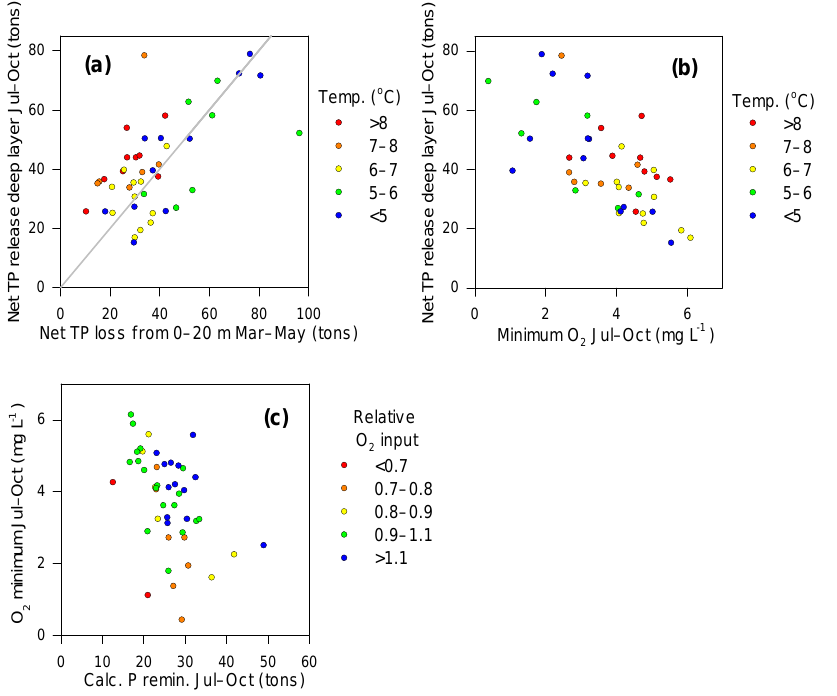
Figure 8. (a) Annual net total phosphorus (TP) release (t) in deep water ( > 20m) in July–October, as a function of net TP loss (t) from the layers 0–20m in March–May 1969–2015 (1970 excluded as an outlier (P loss 222t), 1975 excluded due to lack of data, and 2011 excluded due to unreliable data). The colour code shows mean bottom water temperature for July–October (station K, 24–32m; see Fig. 3). There is a significant linear regression, y = 19 . 8 + 0 . 55 x , r 2 = 0.38, p < 0.0001. Only the 1:1 line is shown in the graph. (b) Annual net TP release in deep water for July–October (t) as a function of the minimum oxygen (O 2 ) concentration (mgL − 1 ). Colour-coded as in (a) . There is a significant linear regression, y = 73 . 2 − 8 . 50 x , r 2 = 0.48, p < 0.0001. (c) Minimum O 2 concentration (mgL − 1 ) as a function of O 2 consumption rate, converted to expected P release (see methods). The colour code shows model-calculated O 2 input to the deep water normalized to the mean O 2 input for all years. A value > 1 indicates a higher O 2 input than the mean value for all years, and a value < 1 indicates a lower O 2 input than the mean for all years. The linear regression is y = 6 . 31 − 0 . 10 x , r 2 = 0.23 ( p < 0.001; however, see Sect.